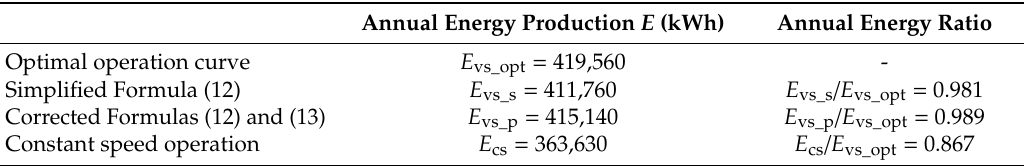
Table 2. Annual energy production comparison.